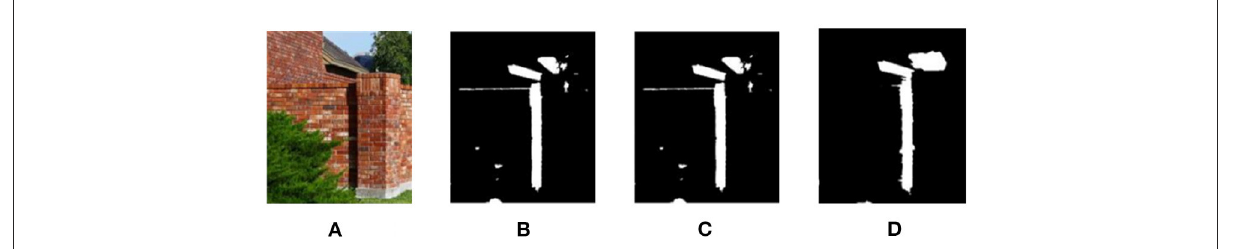
FIGURE5 Analysis of boundary adversarial branch. (A) Shadow image, (B) before boundary adversarial, (C) after boundary adversarial, and (D) detection result.